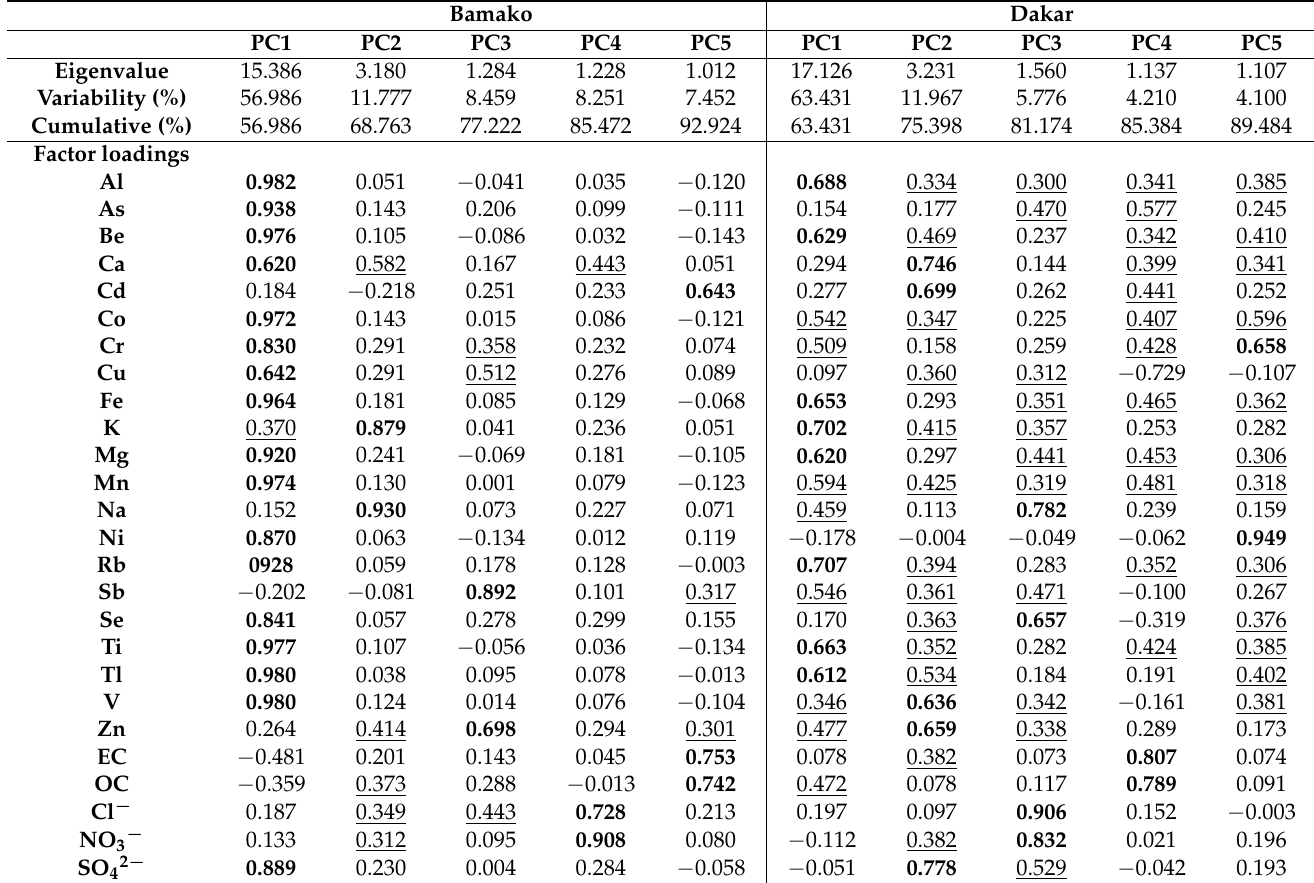
Table 2. Correlations between chemical compounds and principal components (PCs) in Bamako and Dakar (factor loadings ≥ 0.600 are highlighted in bold, while moderate factor loadings (0.300–0.600) are underlined, with categorization based on Nyanganyura et al. [69]). Bamako